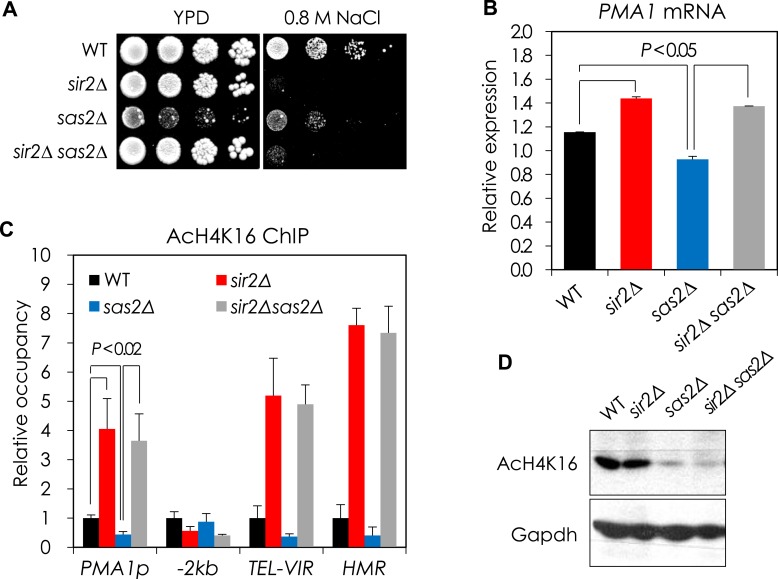
Sir2 and Sas2 antagonistically regulate PMA1 transcription in part through regulating H4K16 acetylation at PMA1 promoter.(A) NaCl sensitivity of WT, sir2∆, sas2∆, and sir2∆ sas2∆ cells. Each cell was spotted onto YPD plates containing 0.8 M NaCl and incubated at 30°C for 3 days. (B) The PMA1 mRNA levels of WT, sir2∆, sas2∆, and sir2∆ sas2∆ cells were analyzed by qRT-PCR. ACT1 was used as a loading control. The values are the average of at least three independent experiments (±S.D.). p values were calculated using t-test. (C) Changes in H4K16 acetylation at the PMA1 promoter were assayed by chromatin immunoprecipitation (ChIP) using an anti-H4K16 antibody in WT, sir2∆, sas2∆, and sir2∆ sas2∆ cells. 2 kb upstream region of the PMA1 promoter (−2 kb) was used as a negative control for Sir2 action. TEL-VIR and HMR are known Sir2 targets. The values are the average of at least three independent experiments (±S.D.). p values were calculated using t-test. (D) Total H4K16 acetylation levels were analyzed by Western blotting using the anti-H4K16 antibody in WT, sir2∆, sas2∆, and sir2∆ sas2∆ cells. GAPDH protein was used as a loading control.